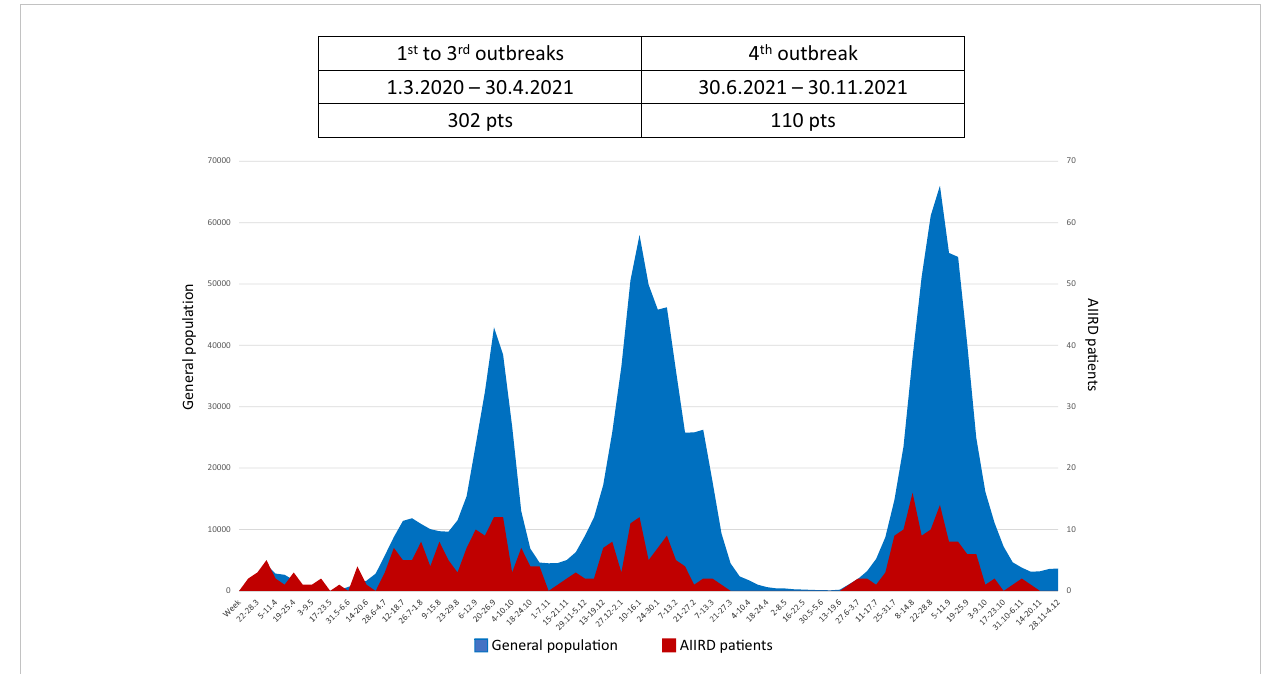
FIGURE 2 The pattern of spread of COVID 19 among AIIRD patients compared to the general